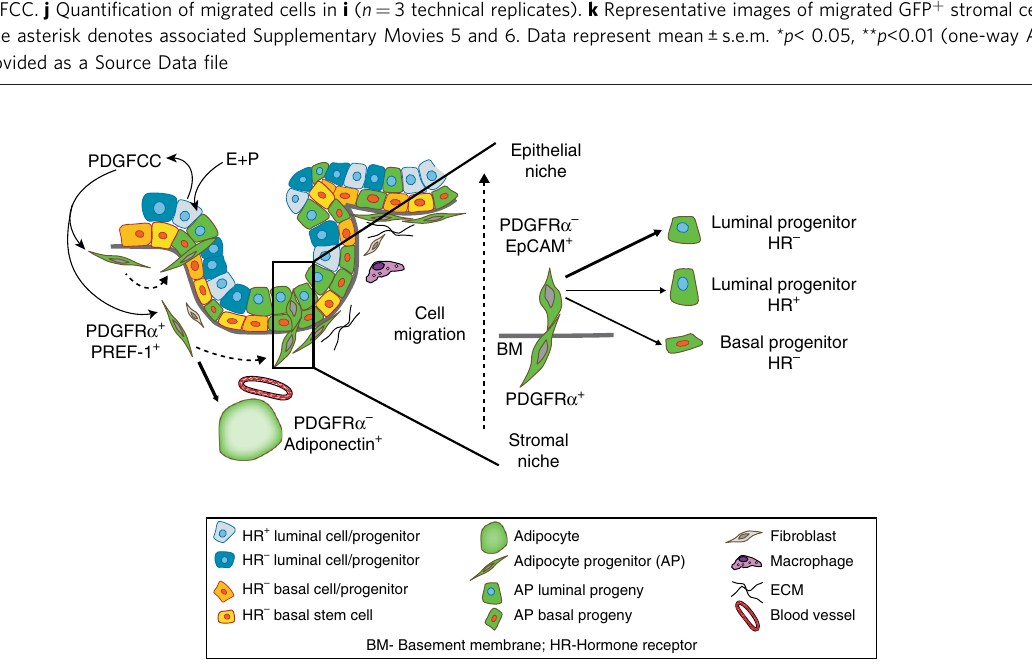
Fig. 7 Stromal progenitors migrate into the mammary epithelium in response to hormone-driven signals. a Sorted samples from untreated ( n = 4) and E + P treated ( n = 3) Pdgfr α Cre R26mTmG adult mice for RNA-seq. b Cellular identity of luminal GFP + , tdTomato + and stromal GFP + , tdTomato + mammary cells. c Read counts per million for adipocyte progenitor genes in indicated mammary subsets. Boxplots depict the upper and lower quartiles, with the median shown as a solid line; whiskers indicate 1.5 times the interquartile range. d Heat map showing clustering of the top 20% most variable genes in all stromal samples. e Top 10% most signi fi cantly enriched pathways for DEGs between GFP + and tdTomato + stromal cells from untreated (U) and E + P- stimulated mice (dot size = # of DEGs / # of genes in pathway). f Heat map of PDGFR ligand ( Pdgf ) expression by RNA-seq in sorted luminal and stromal samples. g qRT-PCR analysis of Pdgf expression relative to β -actin in FACS-sorted subsets isolated from ovariectomized mice treated with vehicle (V), E or tdTomato + organoids derived from sorted epithelial cells of Cre - mice, and left untreated (control) or treated with PDGFCC and imaged over night for ~12 h;